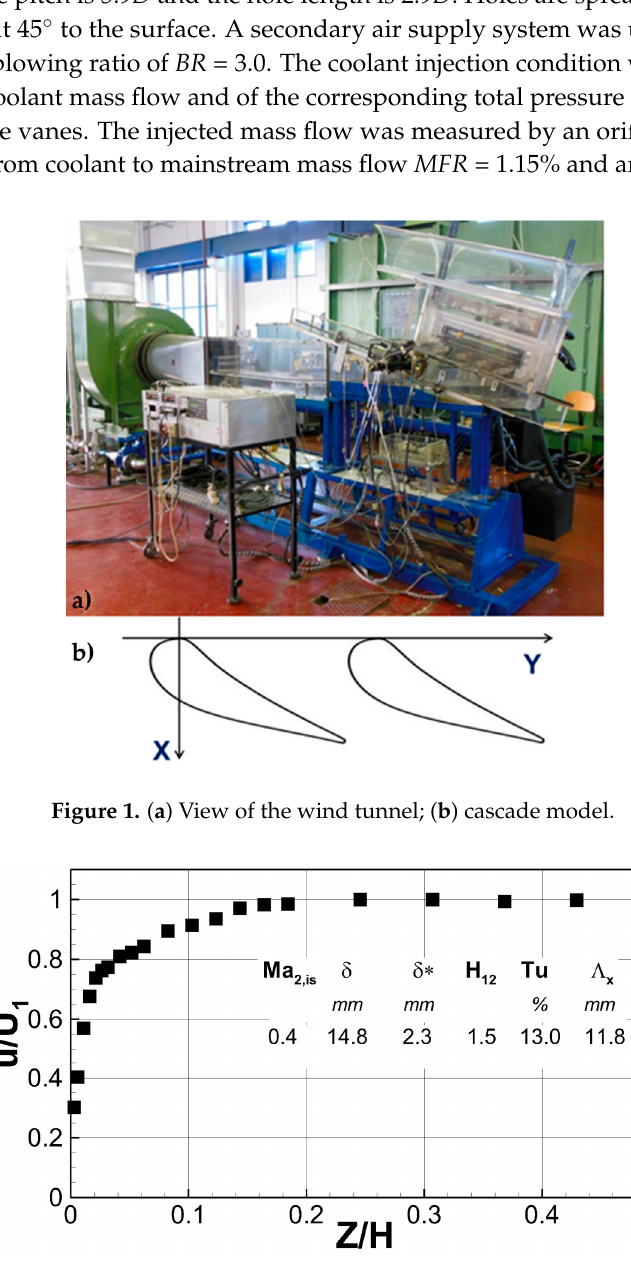
Figure 2. Inlet boundary layer profile ( X/C ax = − 1.6).